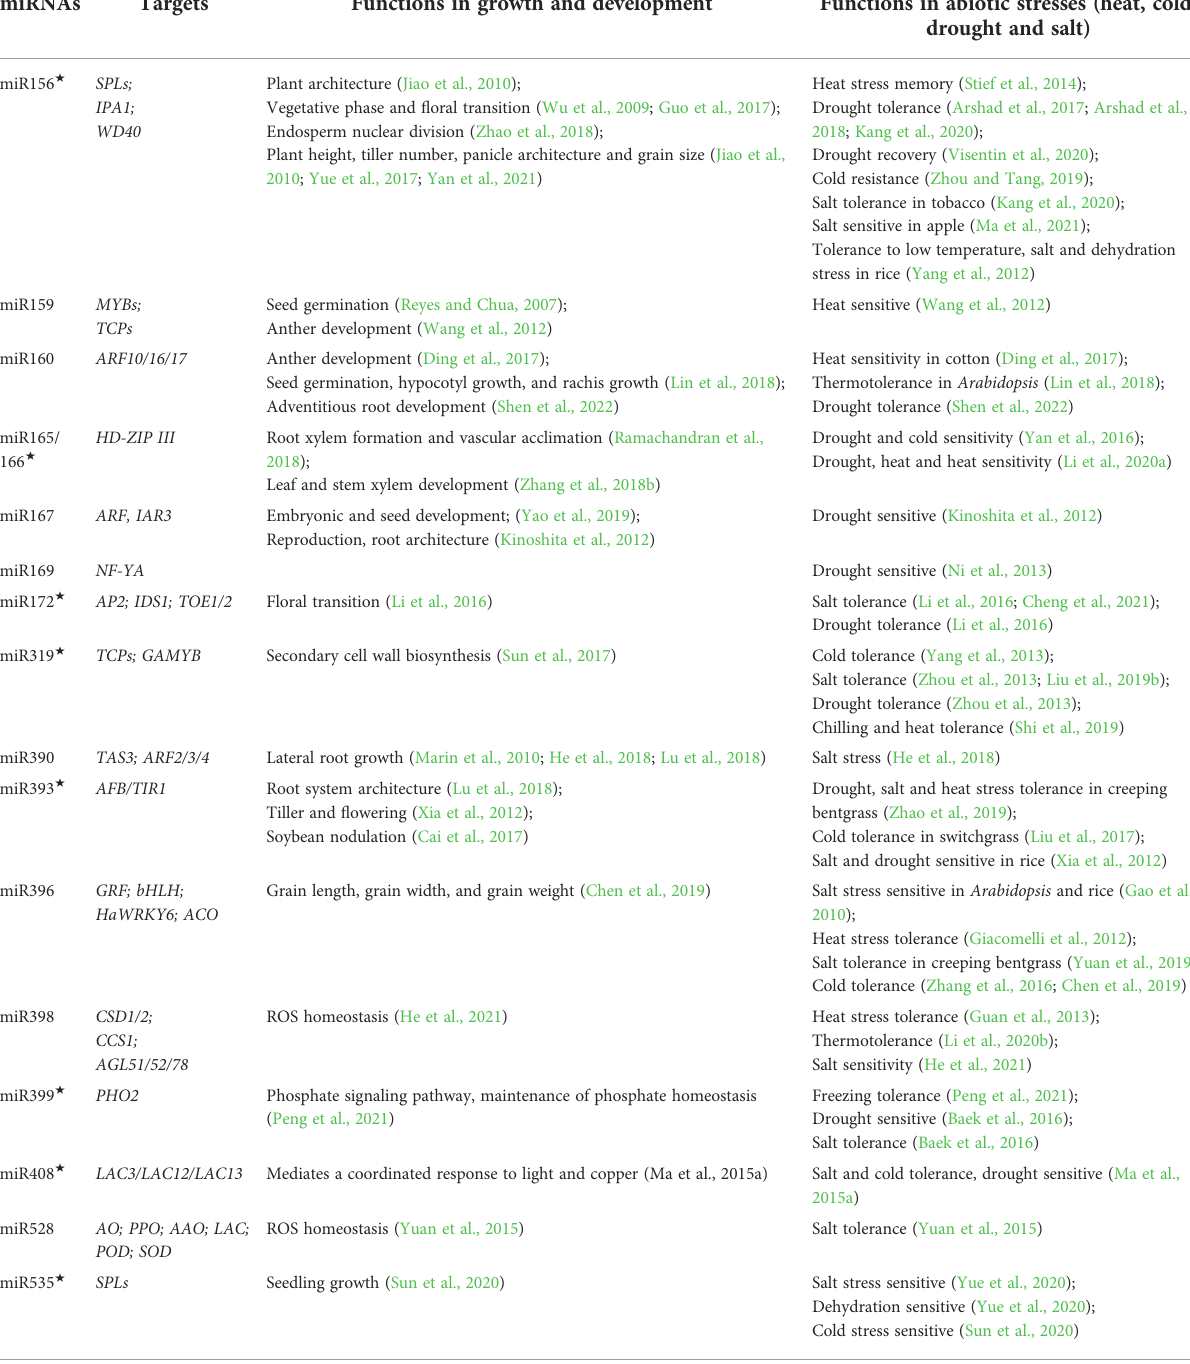
drought and salt)